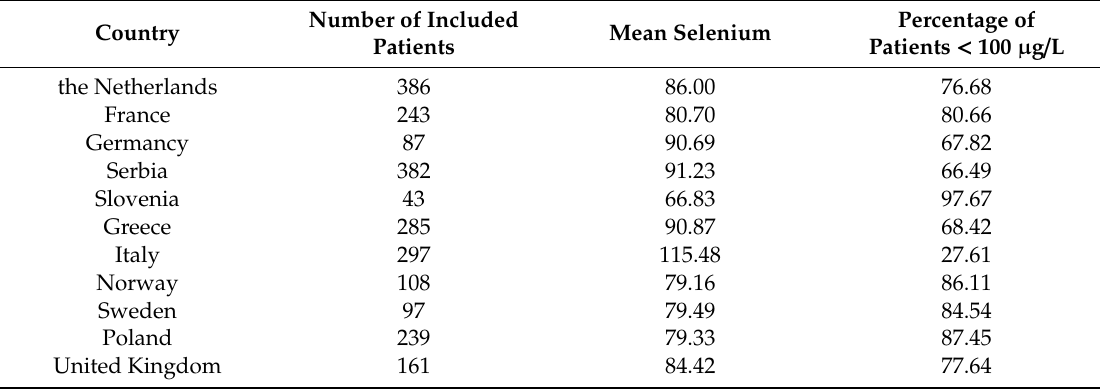
Table A6. Number of patients with selenium < 100 µ g / L per cluster per variable. Factor